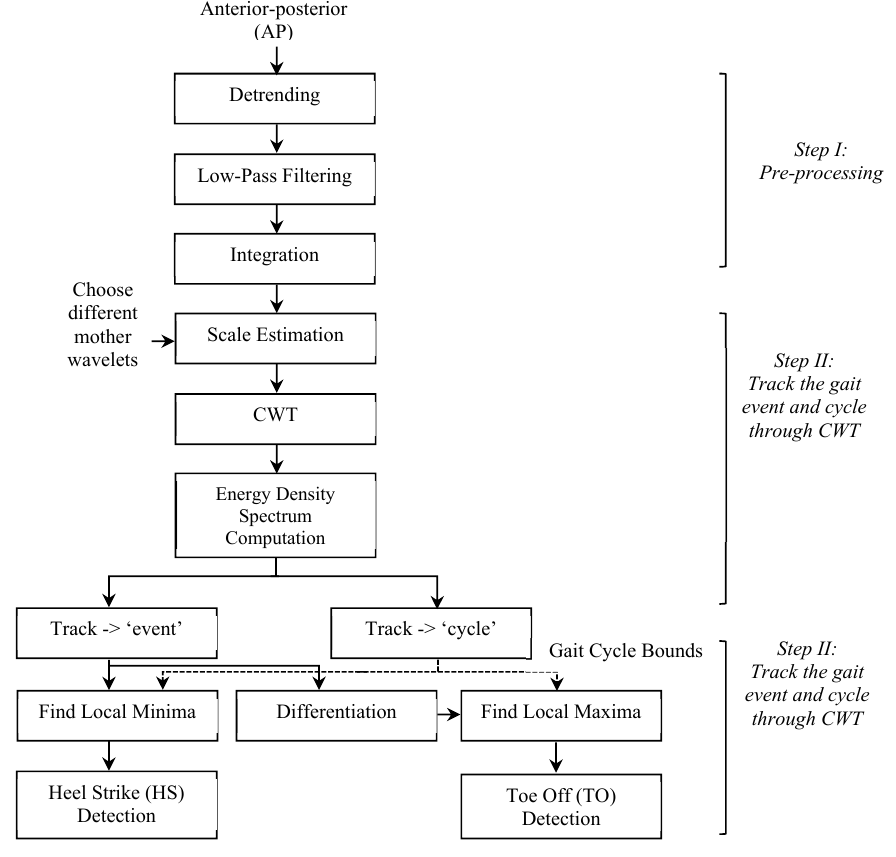
Figure 2. Conceptualization of the proposed general CWT algorithm with three main phases: (1) Pre-processing of the acceleration signals; (2) Tracking the gait events and gait cycles through time-frequency analysis; (3) Distinguishing HS and TO gait events.